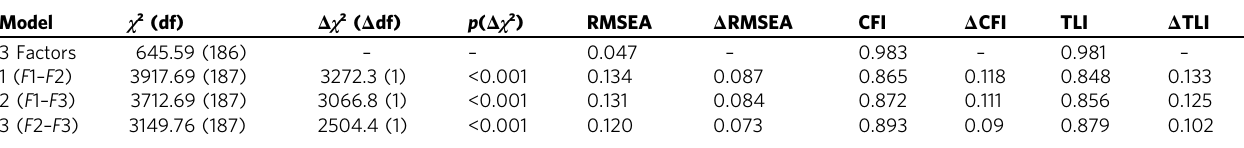
Table 4 Comparison of fi t indexes for the four three-factor